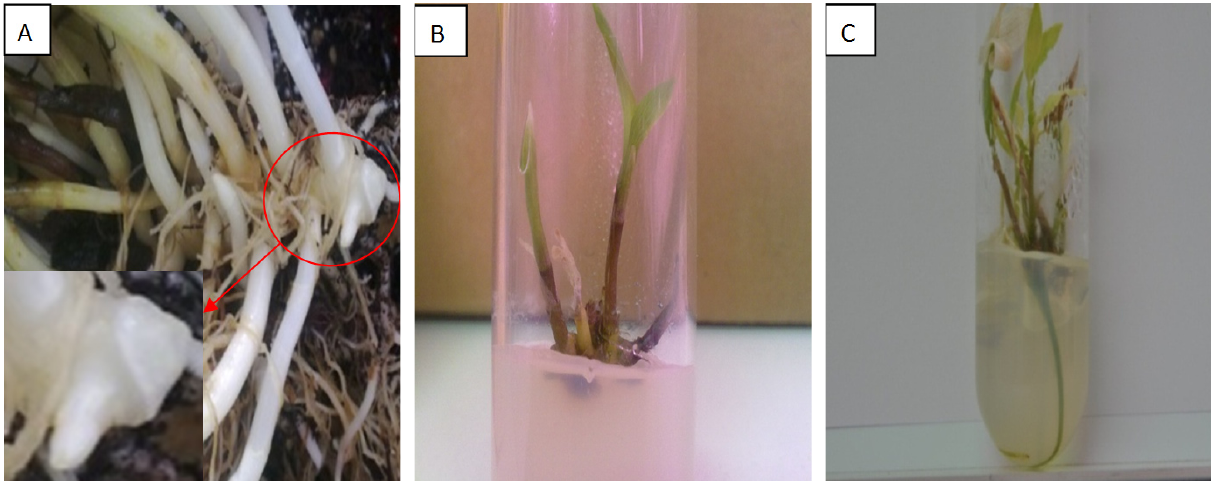
Fig. 1. Explants preparation and in vitro growth (A) preparation of rhizome-tip explants; (B) explants growth and shoot emergence in the 5 th week; (C) rooting in the 7 th